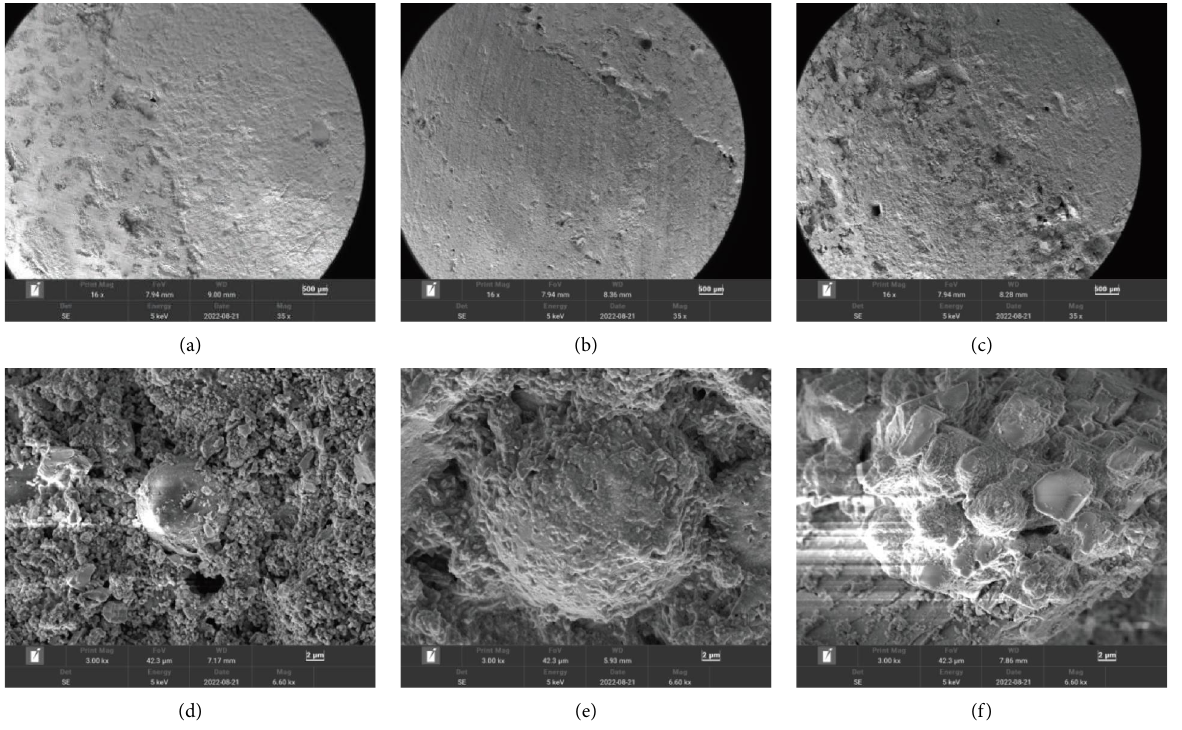
Figure 10: SEM image of 28d fair-faced concrete. (a) 16x SEM image of group AC. (b) 16x SEM image of group SAC. (c) 16x SEM image of group LSAC-20. (d) 3000x SEM image of group AC. (e) 3000x SEM image of group SAC. (f) 3000x SEM image of group